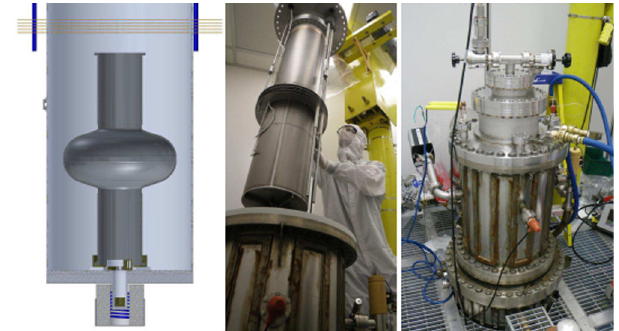
FIG. 2. Performance curves at 2.0 K and 4.2 K for one of the best Nb 3 Sn cavities produced by U. Wuppertal [16]. The approximate values that could be expected for an equivalent Nb cavity are shown for comparison.